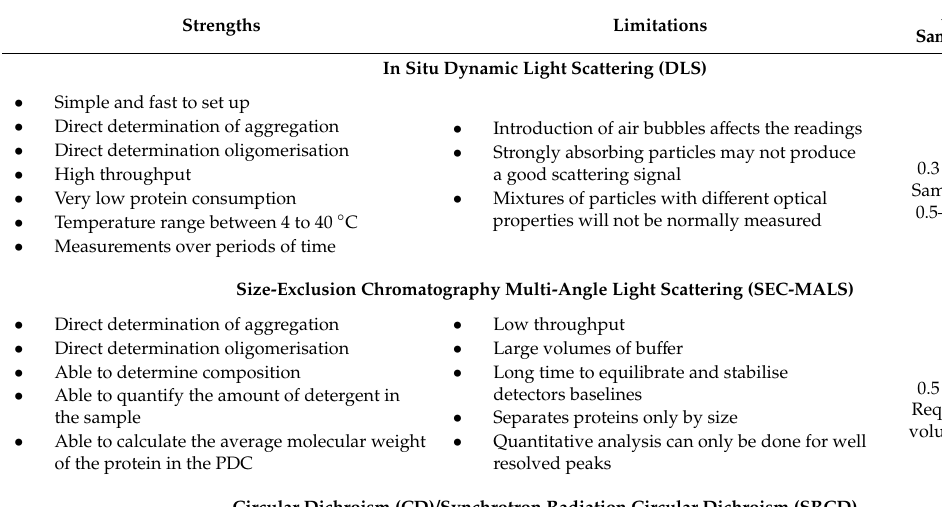
Table 1. Strengths and limitations of the biophysical methods presented in this